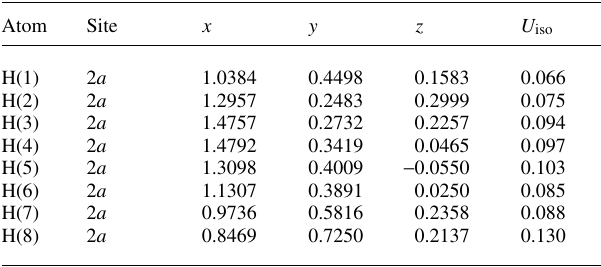
Table 2. Atomic coordinates and displacement parameters (in Å 2 )